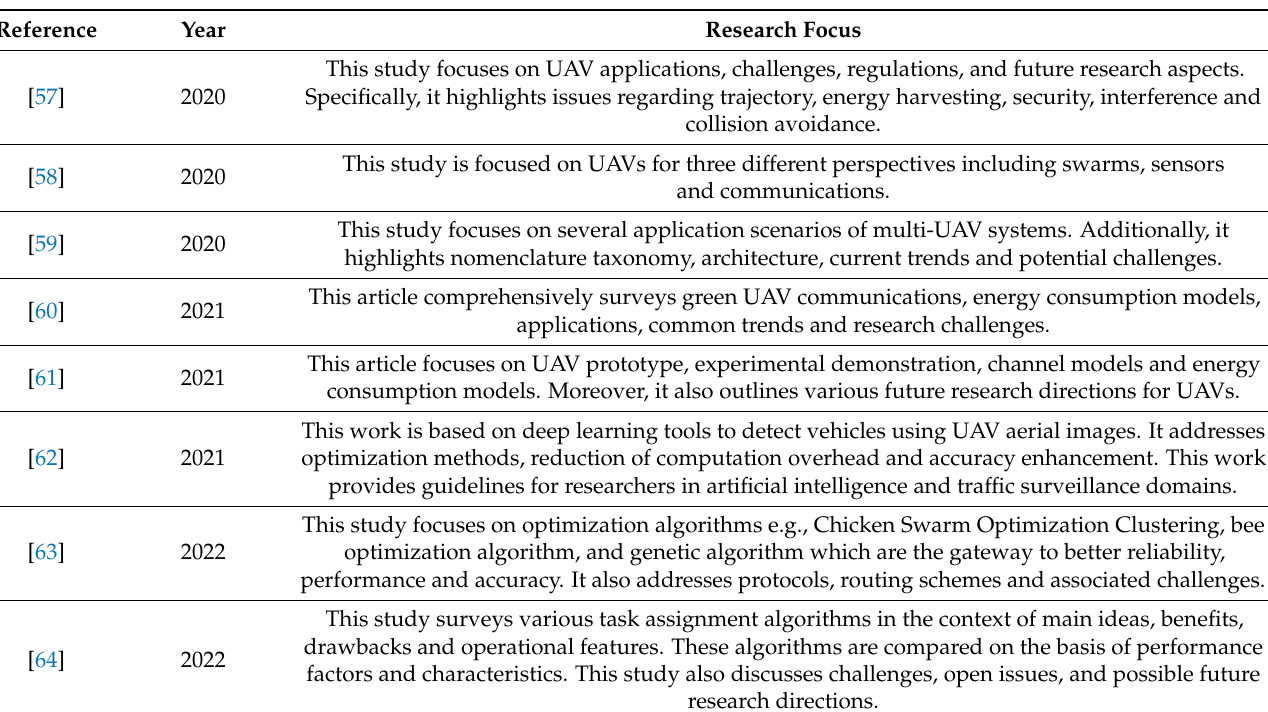
Figure 6. Controlling EM reflection via varactor-tuned resonators. Table 5. Research contributions on